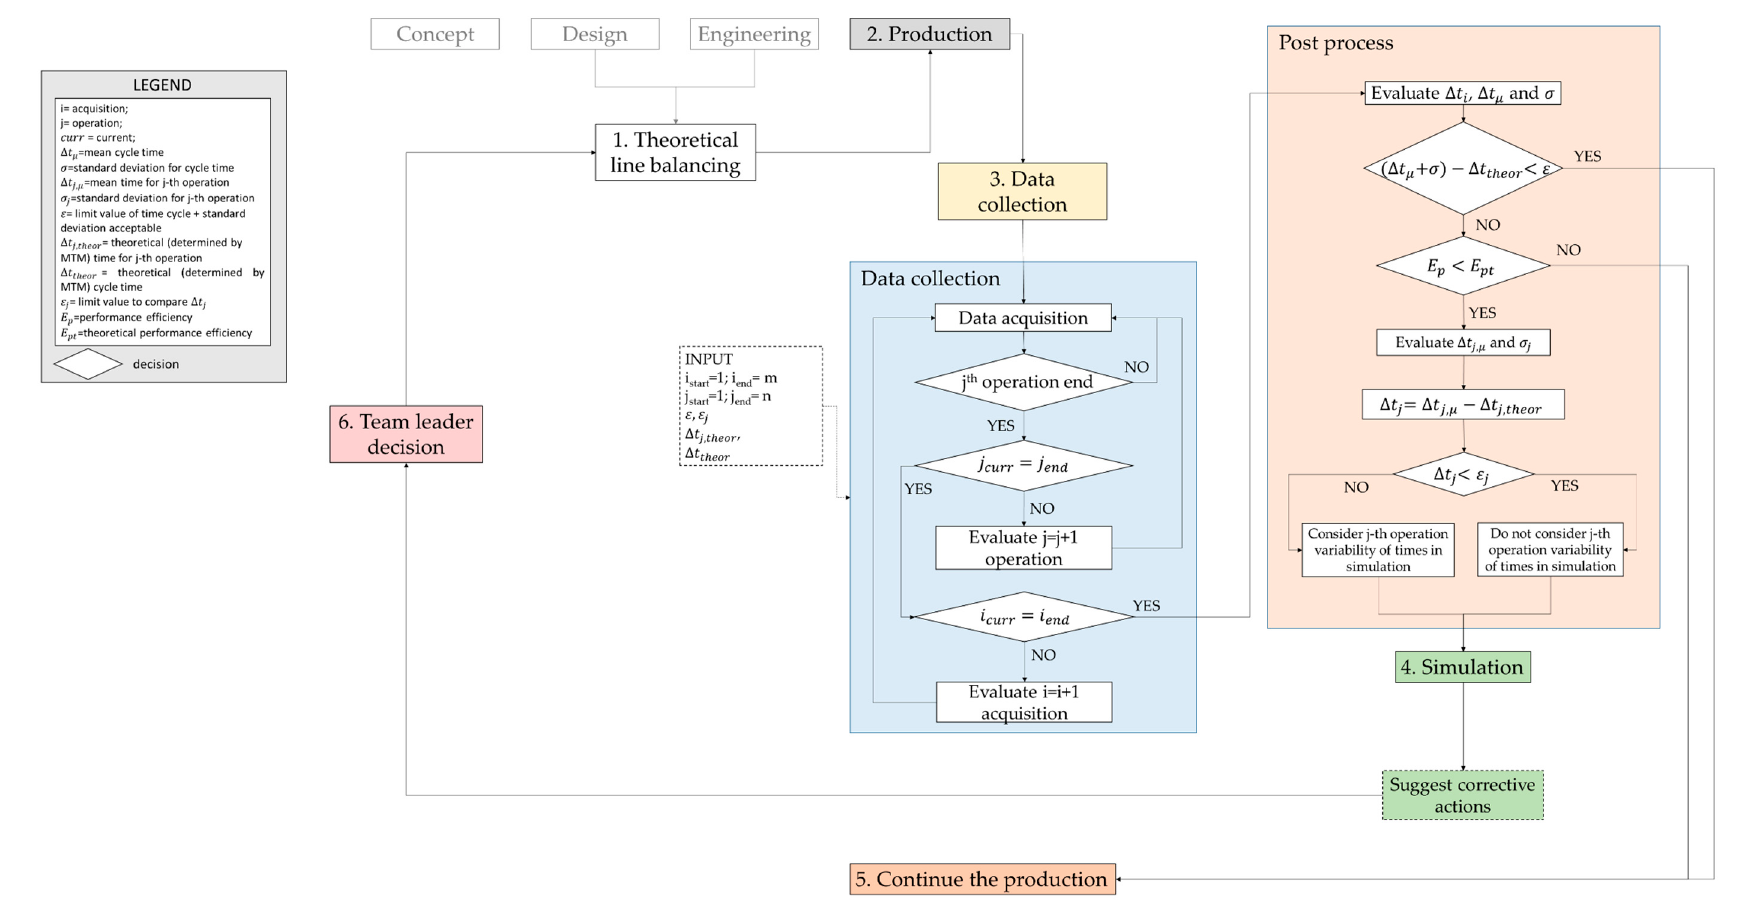
Figure 1. General methodological framework for evaluating the line performance during the production.